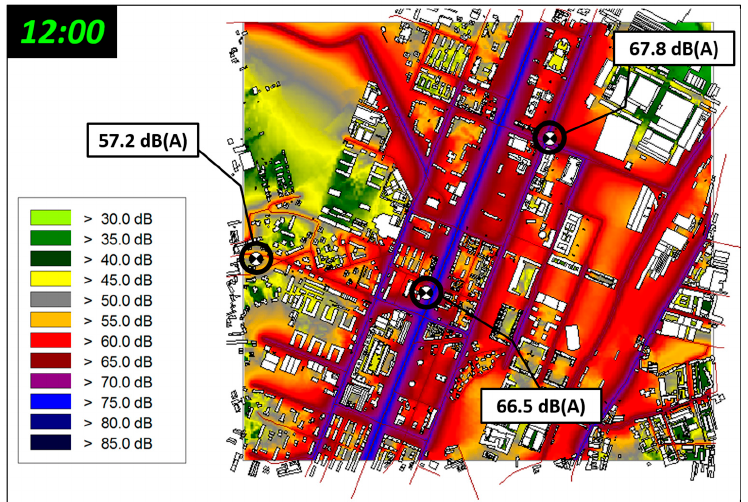
Figure 12. Illustration of a typical outcome of Dynamap showing in different colors different noise levels as indicated in the inset. In the plot, we show the location of three monitoring stations (black circles).